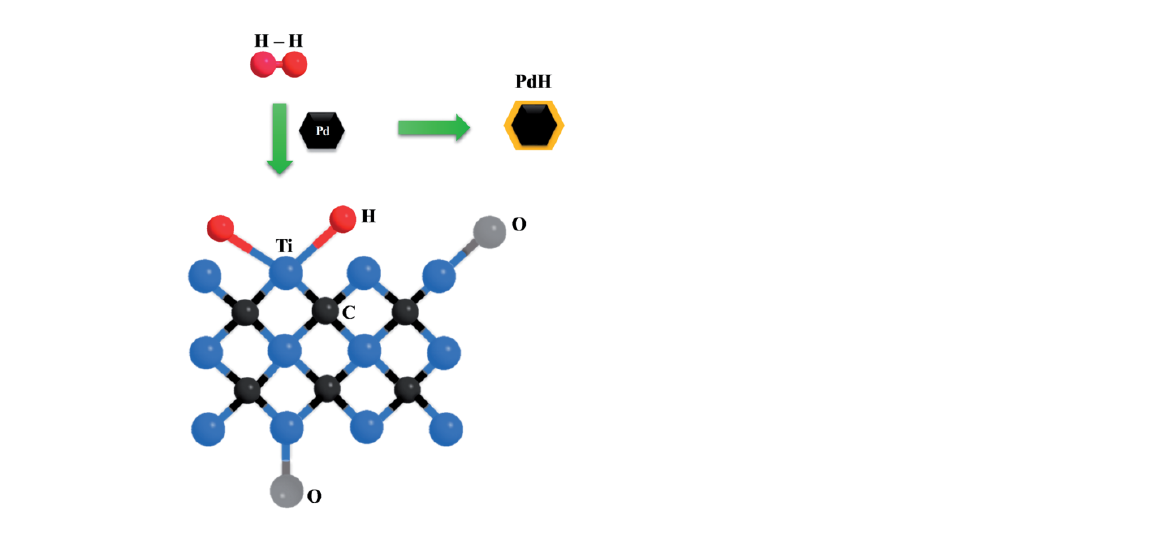
Figure 17. ( a ) Gas sensor response of MXene film, rGO fiber and MXene/rGO hybrid fiber to 50 ppm NH 3 at room temperature. ( b ) Gas sensor response of rGO fiber and MXene/rGO hybrid fiber to various testing gases at concentrations of 50 ppm. Republished with permission from [87]. Copy- right © 2020, American Chemical Society.